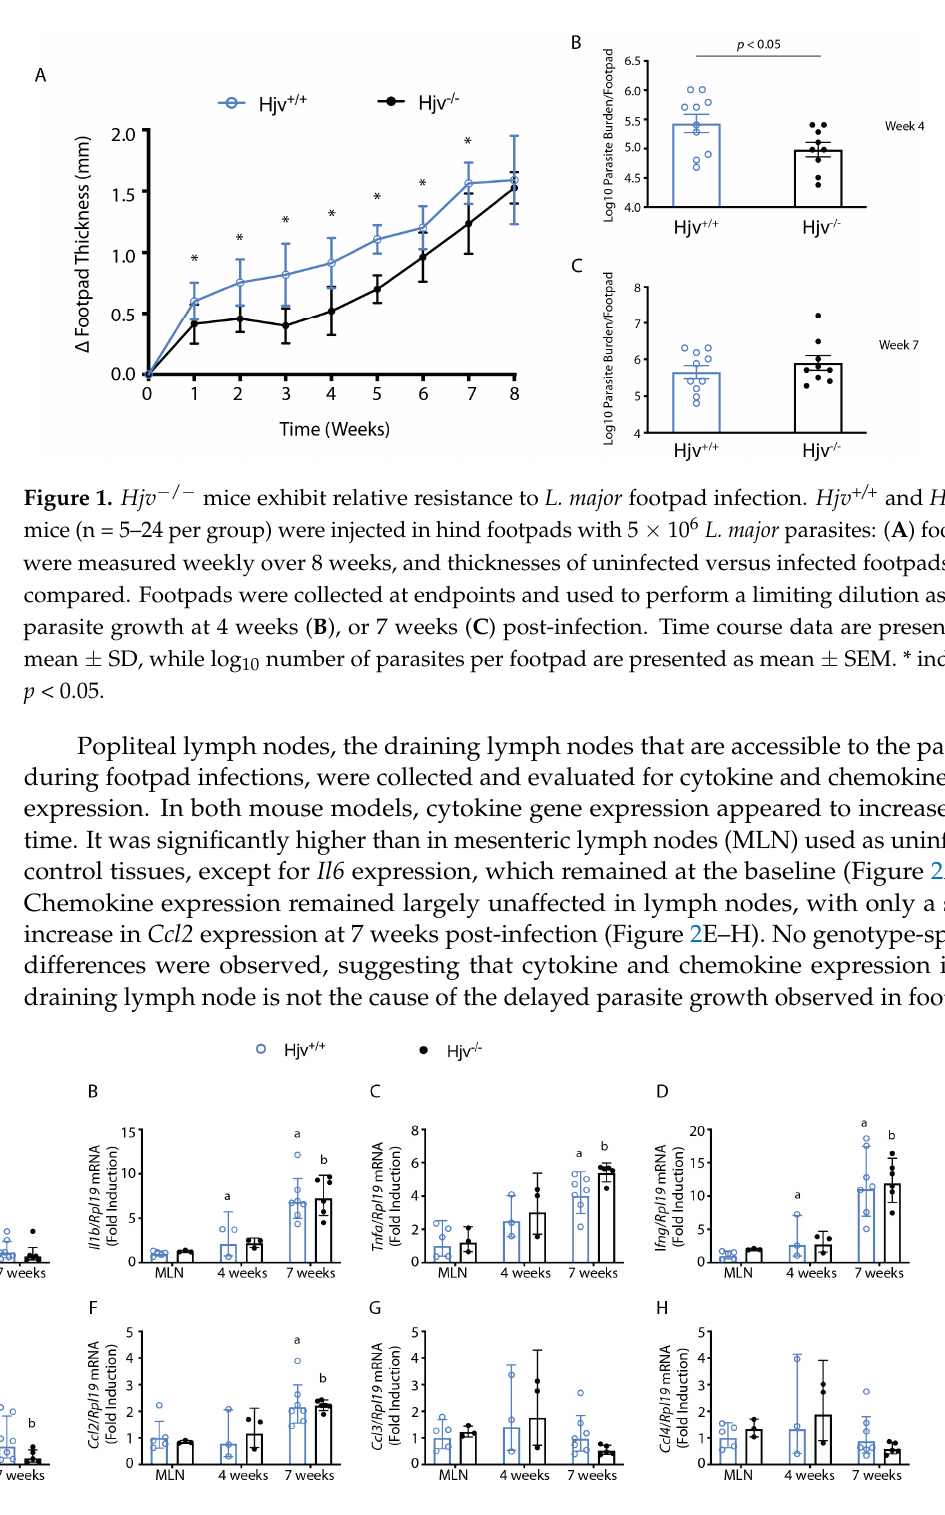
Figure 2. Popliteal lymph node cytokine expression following footpad infection. Popliteal lymph nodes were collected from Hjv +/+ and Hjv − / − mice infected with 5 × 10 6 L. major in hind footpads 4 or 7 weeks post-infection. Mesenteric lymph nodes (MLN) were also collected as uninfected control organs. RNA was extracted, reverse-transcribed, and used for qPCR analysis of ( A ) Il6 , ( B ) Il1b , ( C ) Tnfa , ( D ) Ifng , ( E ) Cxcl2 , ( F ) Ccl2 , ( G ) Ccl3 , and ( H ) Ccl4 mRNAs. Data are presented as geometric mean ± geometrical SD. Statistical differences compared with MLN from Hjv +/+ or Hjv − / − mice are indicated by a or b, respectively.